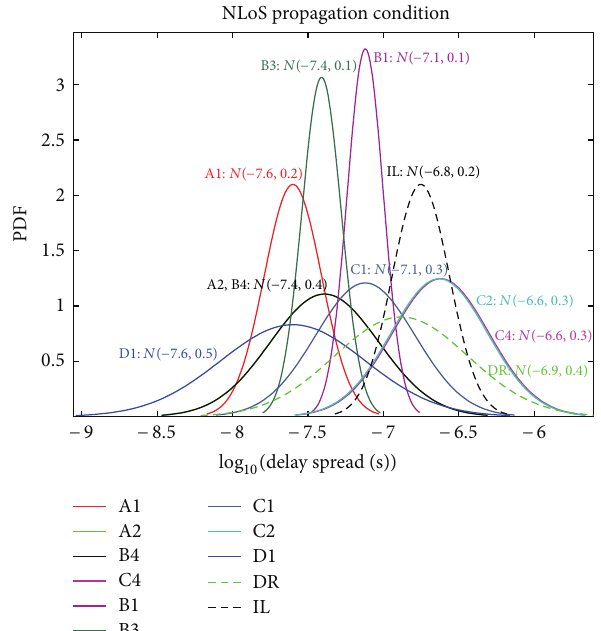
Figure 3: Delay spread PDFs in transformed